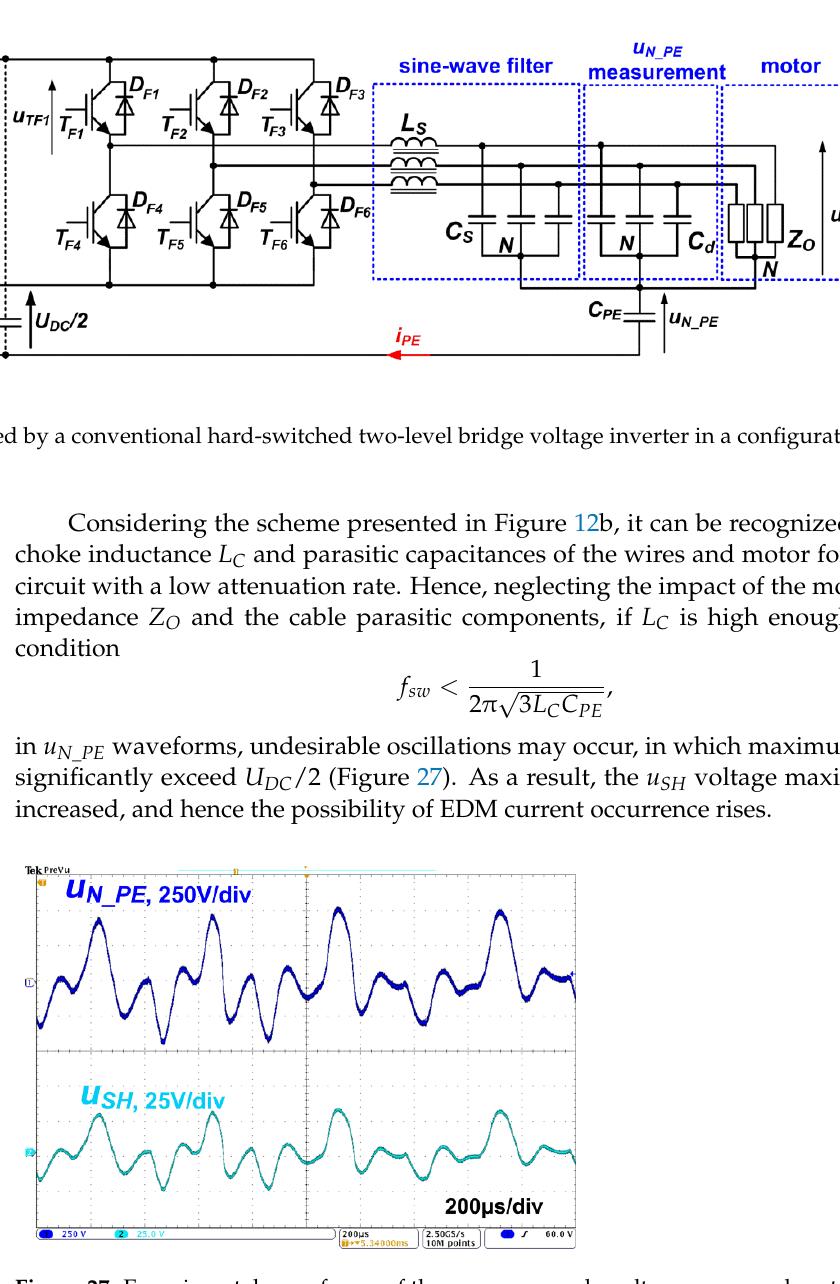
Figure 27. Experimental waveforms of the common-mode voltage u N_PE and motor shaft voltage u SH of a motor fed by the AC10 10G-44-0170-BF (Parker) inverter in a configuration with a CM choke with increased inductance L C ( L C = 28 mH).